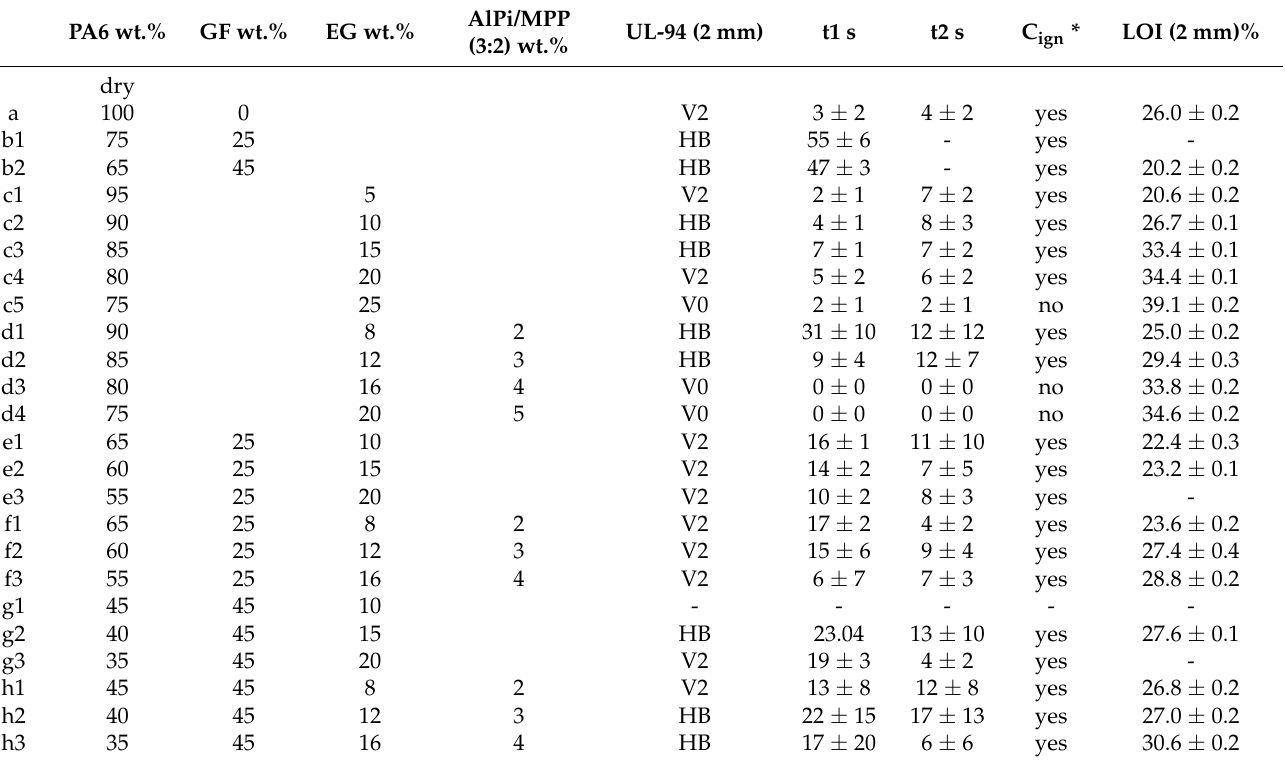
Table 3. Summary of UL-94 and LOI testing